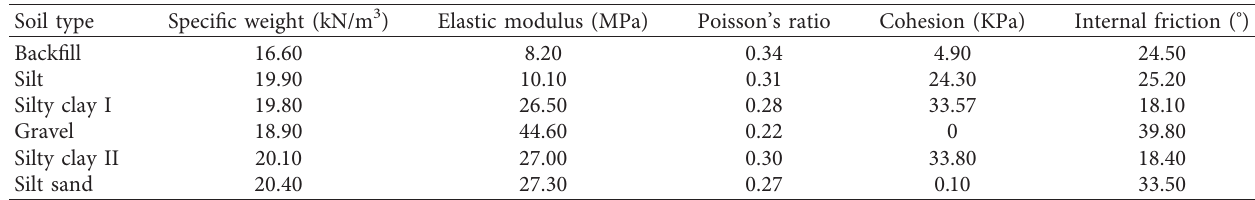
Figure 11: Longitudinal and transverse profile of the Qinghuayuan Tunnel Project. Table 1: Physical and mechanical properties of soils.